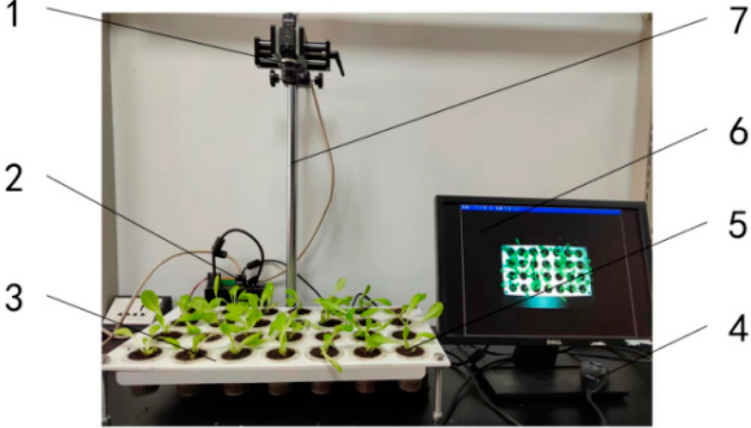
Figure 9. Test equipment: 1. Camera. 2. Controller. 3. Seedling tray. 4. Operating handle. 5. Transplanting cup. 6. Monitor. 7. Stand.